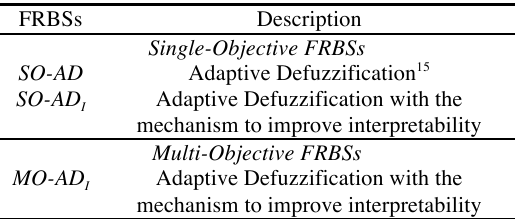
Table 4 Methods considered for comparison